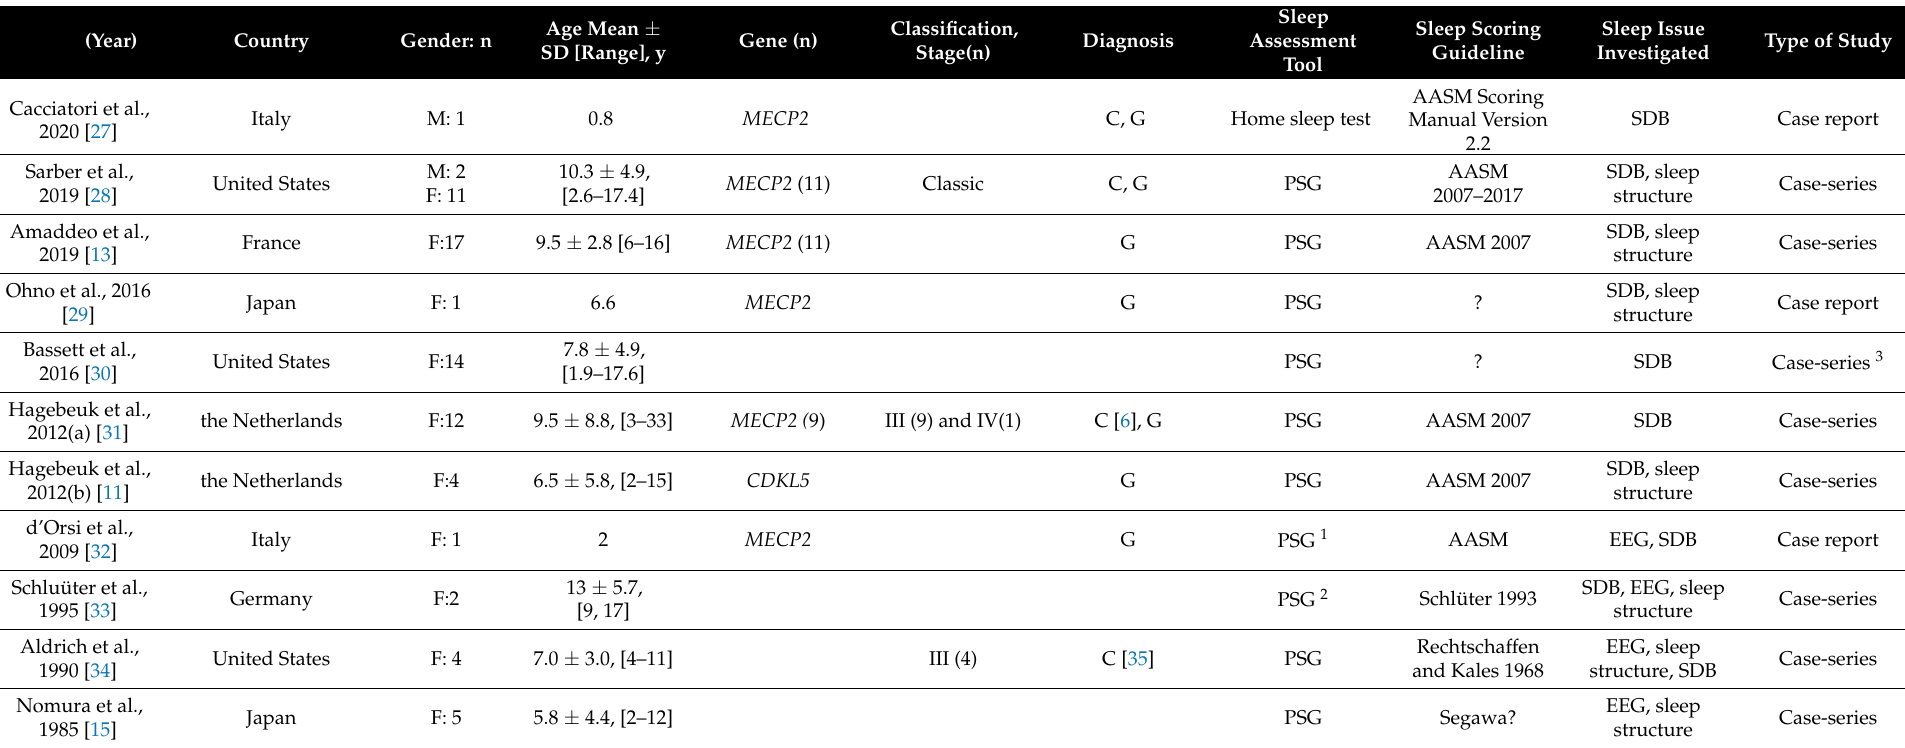
Table 1. Demographic information for the studies